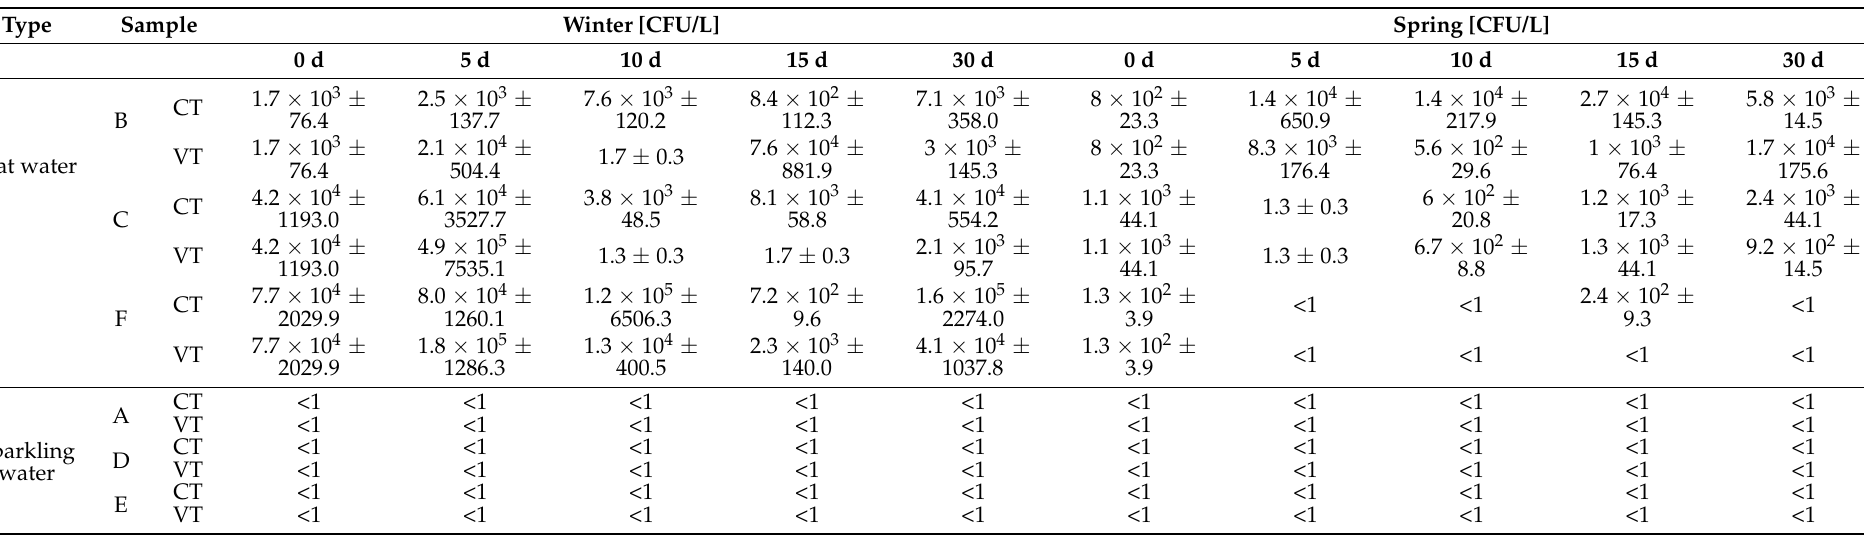
Table 2. Results expressed in CFU/L obtained by shelf-life analysis on unopened bottles considering two seasons (winter and spring) at different storage conditions (controlled and variable temperatures): evaluations were performed for 30 days, at t 0 , and after 5, 10, 15, 30